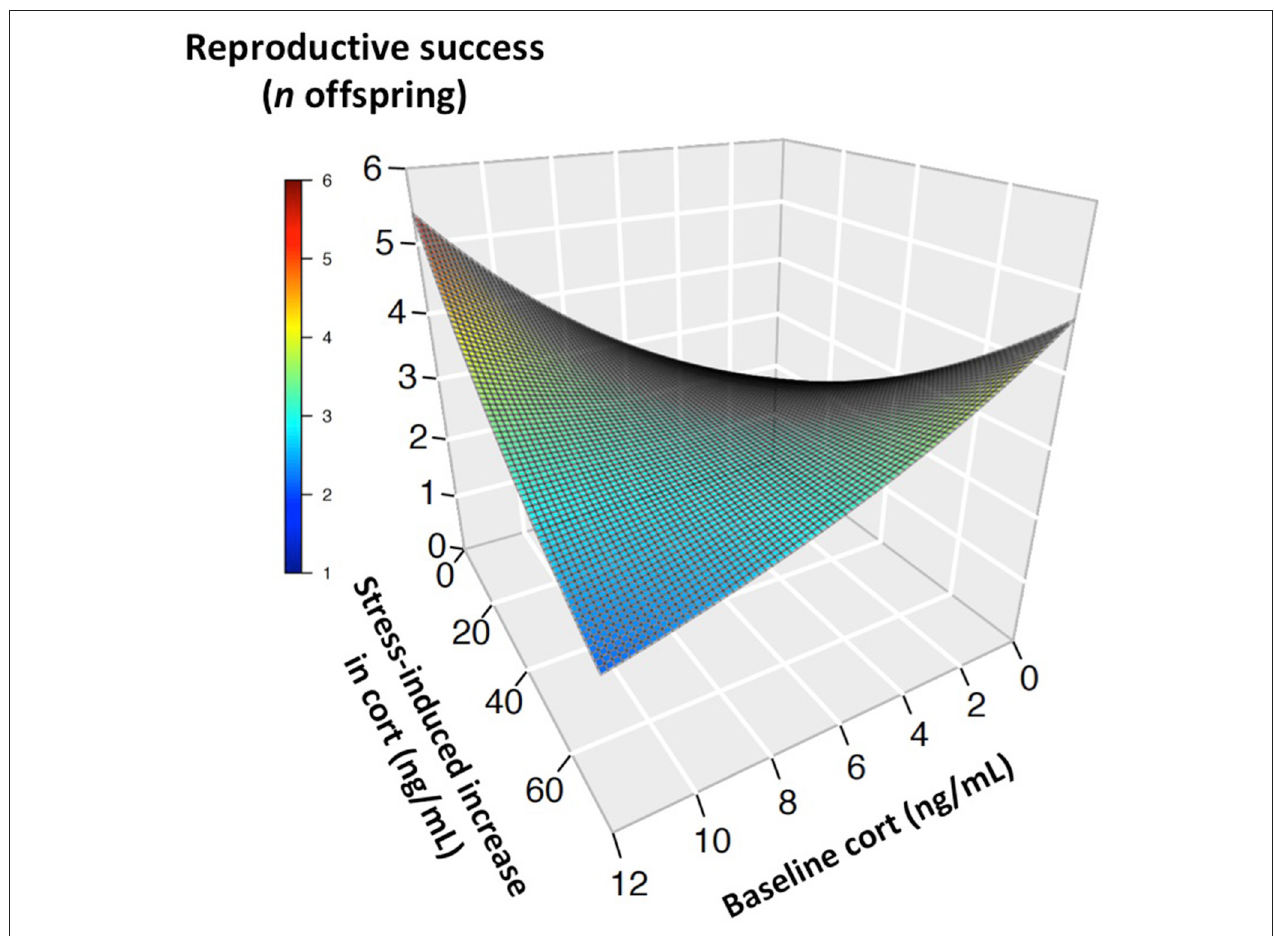
FIGURE 2 | Glucocorticoids and reproductive success in provisioning female tree swallows. Three-dimensional surface plot illustrates the relationship between baseline corticosterone, the stress-induced increase in glucocorticoids, and the number of offspring reared to independence, as predicted by generalized linear mixed models. The highest reproductive success was seen in individuals with low baseline corticosterone coupled with a high stress-induced increase (right side of surface), or with high baseline corticosterone coupled with a low stress-induced increase (left side of